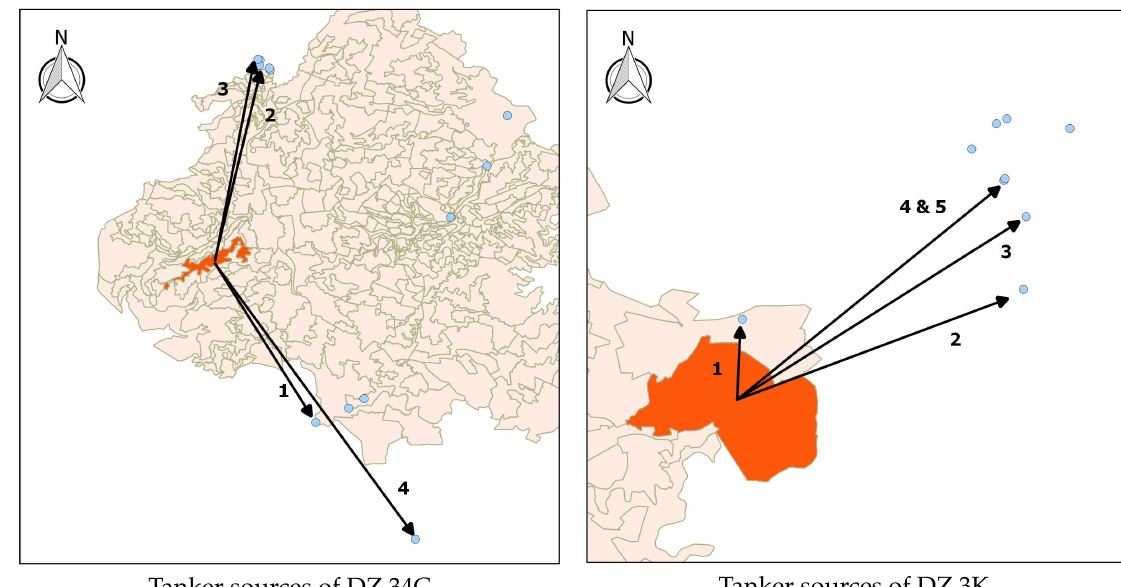
Figure 6. Simulated succession of well exploitation of establishments in selected